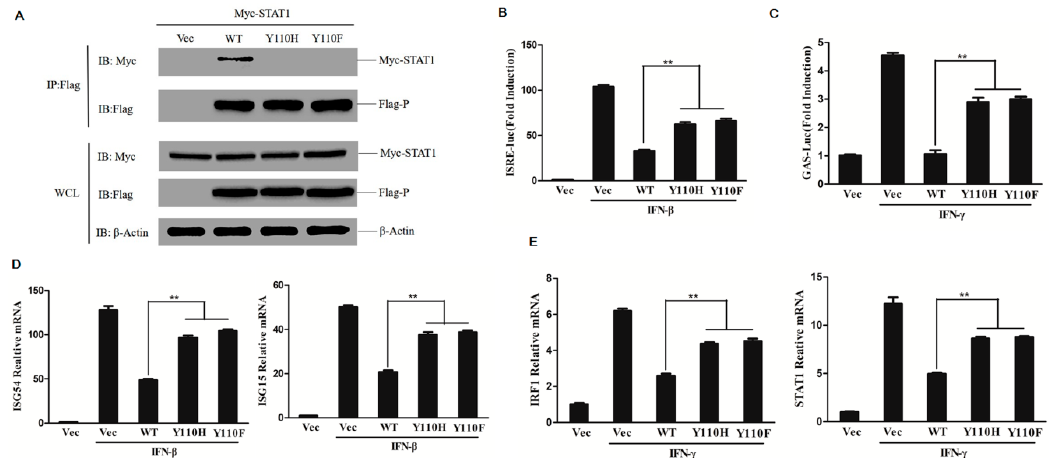
Figure 7. Tyrosine 110 of the P protein is a key site for P–STAT1 interaction and inhibition of IFN response. ( A ) HEK-293T cells were co-transfected with Myc-tagged STAT1 expression plasmids and empty vector, P protein, Y110H mutant or Y110F mutant. Immunoprecipitation (IP) and whole-cell lysates were analyzed by immunoblotting (IB) using anti-Myc, anti-Flag, and anti- β -actin antibodies. ( B and C ) HEK-293T cells were transfected ISRE ( B ) or GAS ( C ) reporter plasmids along with pRL-TK plasmids, and P protein expressing plasmids, Y110H or Y110F. The cells were treated with IFN- β (1000 U / mL) or IFN- γ (100 ng / mL) for 12 h at 24 h post-transfection, and the luciferase activity was determined. ( D and E ) HEK-293T cells were transfected with empty vector or P protein expressing plasmids, Y110H or Y110F, and the cells were treated with IFN- β (1000 U / mL) ( D ) or IFN- γ (100 ng / mL) ( E ) for 12 h at 24 h post-transfection. The relative mRNA expression levels of ISG54 , ISG15 , IRF1, and STAT1 were measured by qPCR analysis.